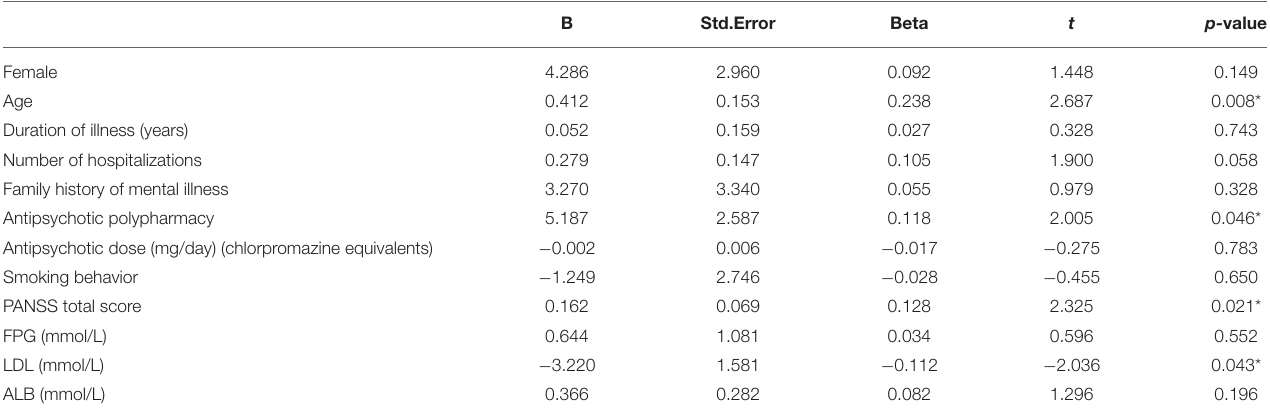
TABLE 5 | The significant predictive variables associated with QTc by multiple regression analysis.